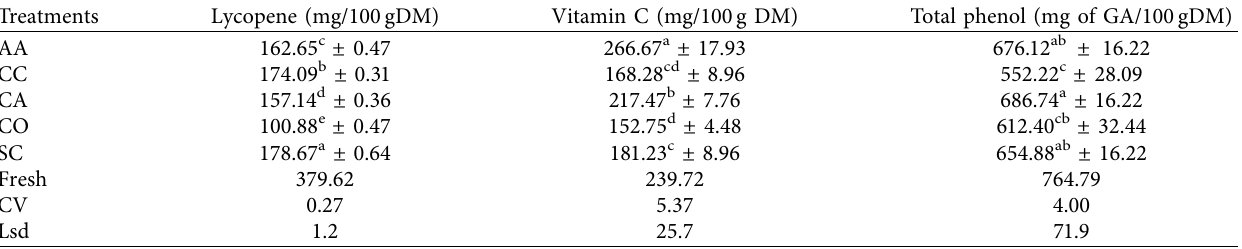
Figure 3: Variation in air temperature and relative humidity in the twin layer solar tunnel dryer and ambient air during drying. Ts � temperature of air in the twin layer solar tunnel dryer, Ta ambient air temperature, RHa � relative humidity of ambient air, and RH � relative humidity of air in the twin layer solar tunnel dryer. Table 1: Effect of predrying treatment on lycopene (mg/100 gDM), vitamin C, and total phenolic content of twin-layer-solar-tunnel-dried tomato samples.